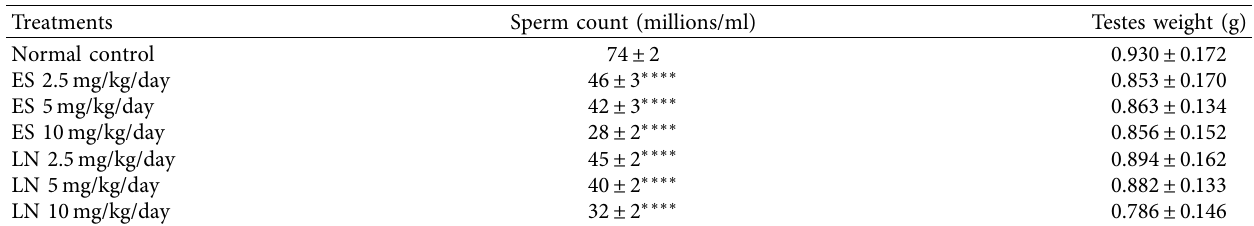
Table 2: Effect of treatment with esomeprazole (ES) and lansoprazole (LN) on sperm count and testes weight in male rats.